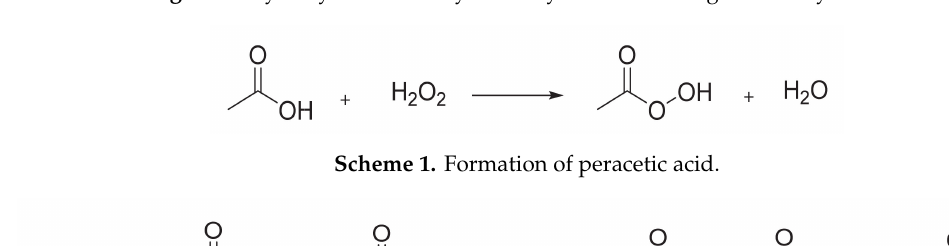
Figure 8. Hydrolysis of the ethylene vinyl acetate leading to carboxylic acid.